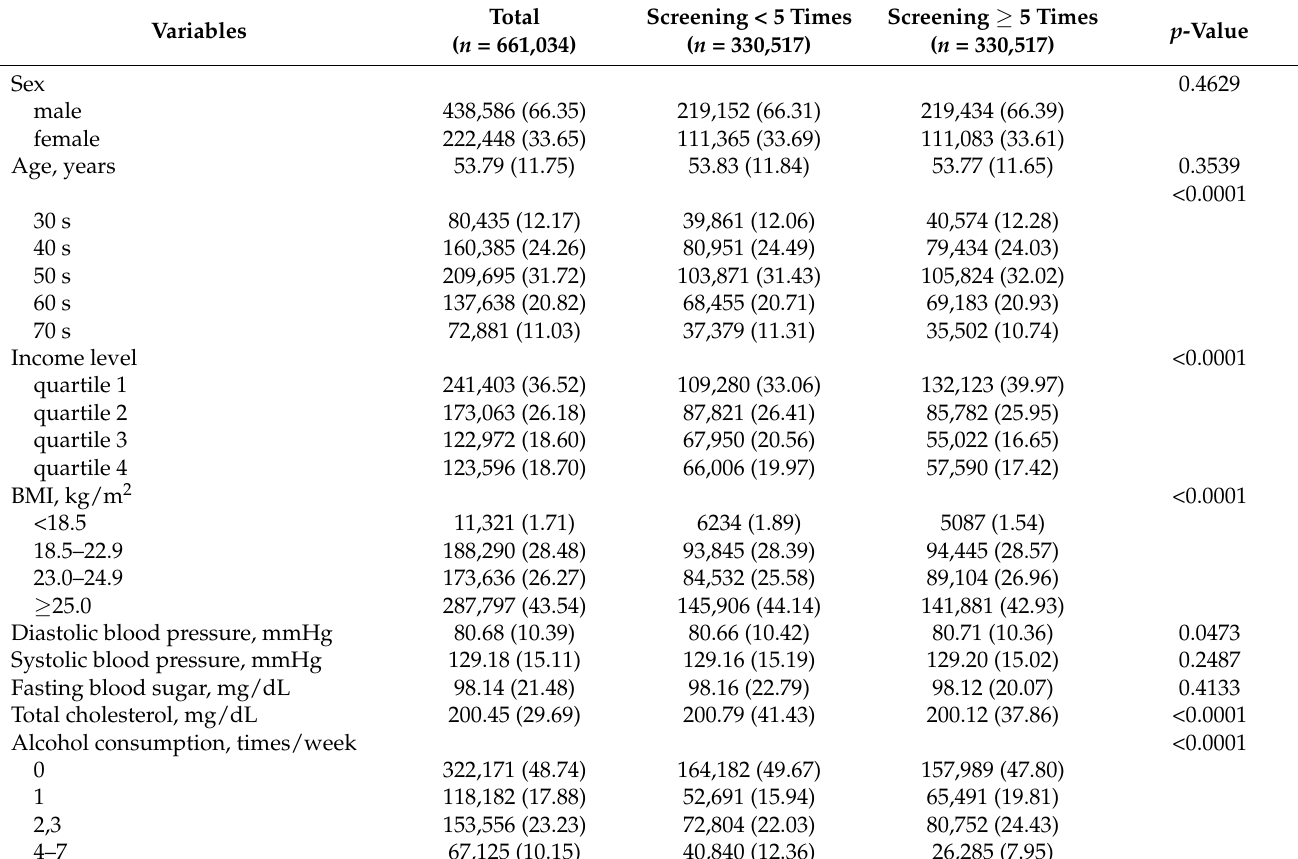
Table 1. Baseline Characteristics after Propensity Score